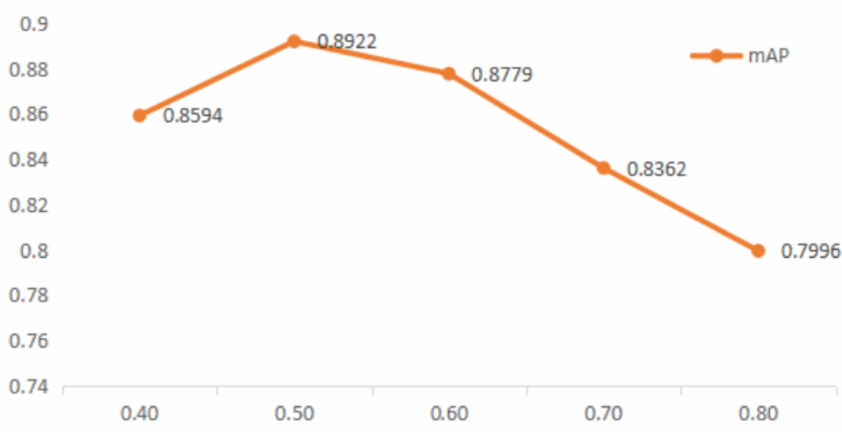
Figure 7. Effects of IoU threshold (VGG19).